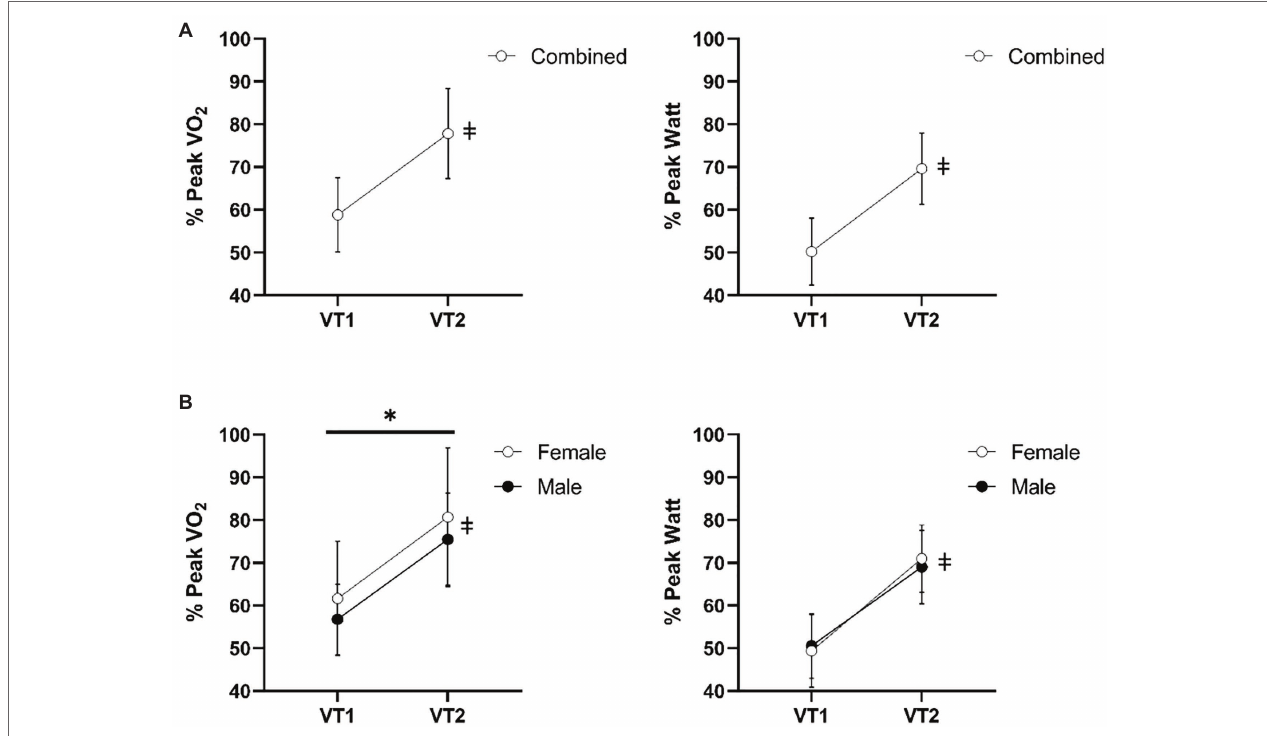
FIGURE 4 | Exercise intensities at VT 1 and VT 2 relative to peak VO 2 and peak W for the combined analysis (A) and sex differences (B) . *Indicates group main effect differences P < 0.001. ǂ indicates significant main effect difference between VT 1 and VT 2 p < 0.0001. Data reported as means ±